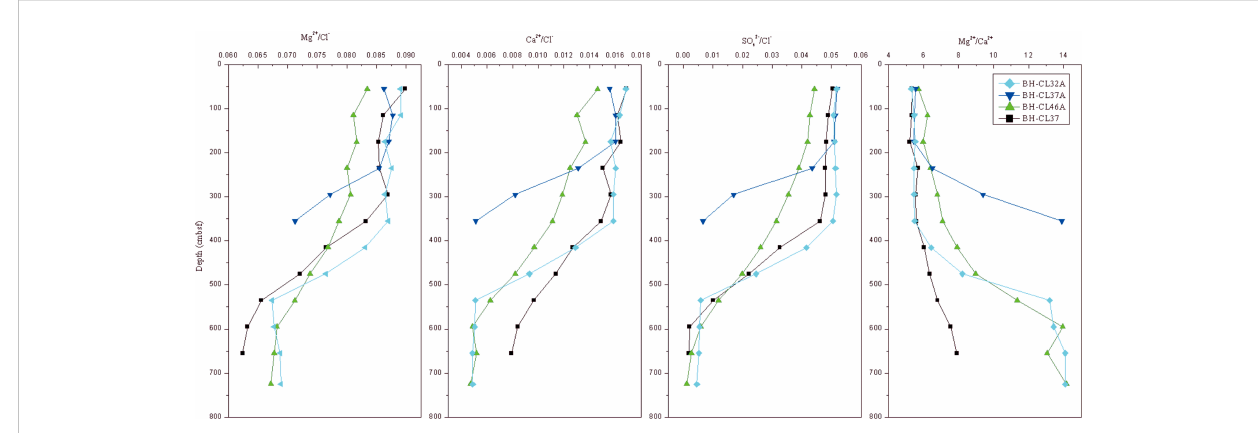
FIGURE 3 Depth pro fi les of Mg 2+ /Cl - , Ca 2+ /Cl - , SO 2- 4 /Cl - and Mg 2+ /Ca 2+